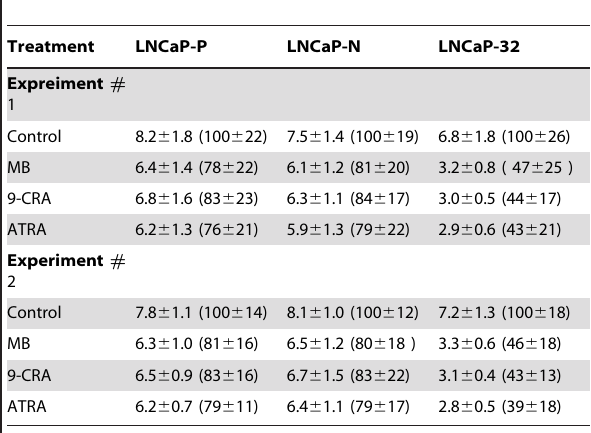
Table 3. Cx32 expression sensitizes LNCaP cells to growth inhibitory effect of 9-CRA, ATRA and MB.